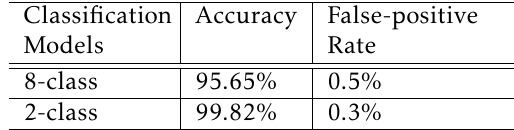
Table 8. Accuracy and False-positive Rate for 8-class and 2- class SAE